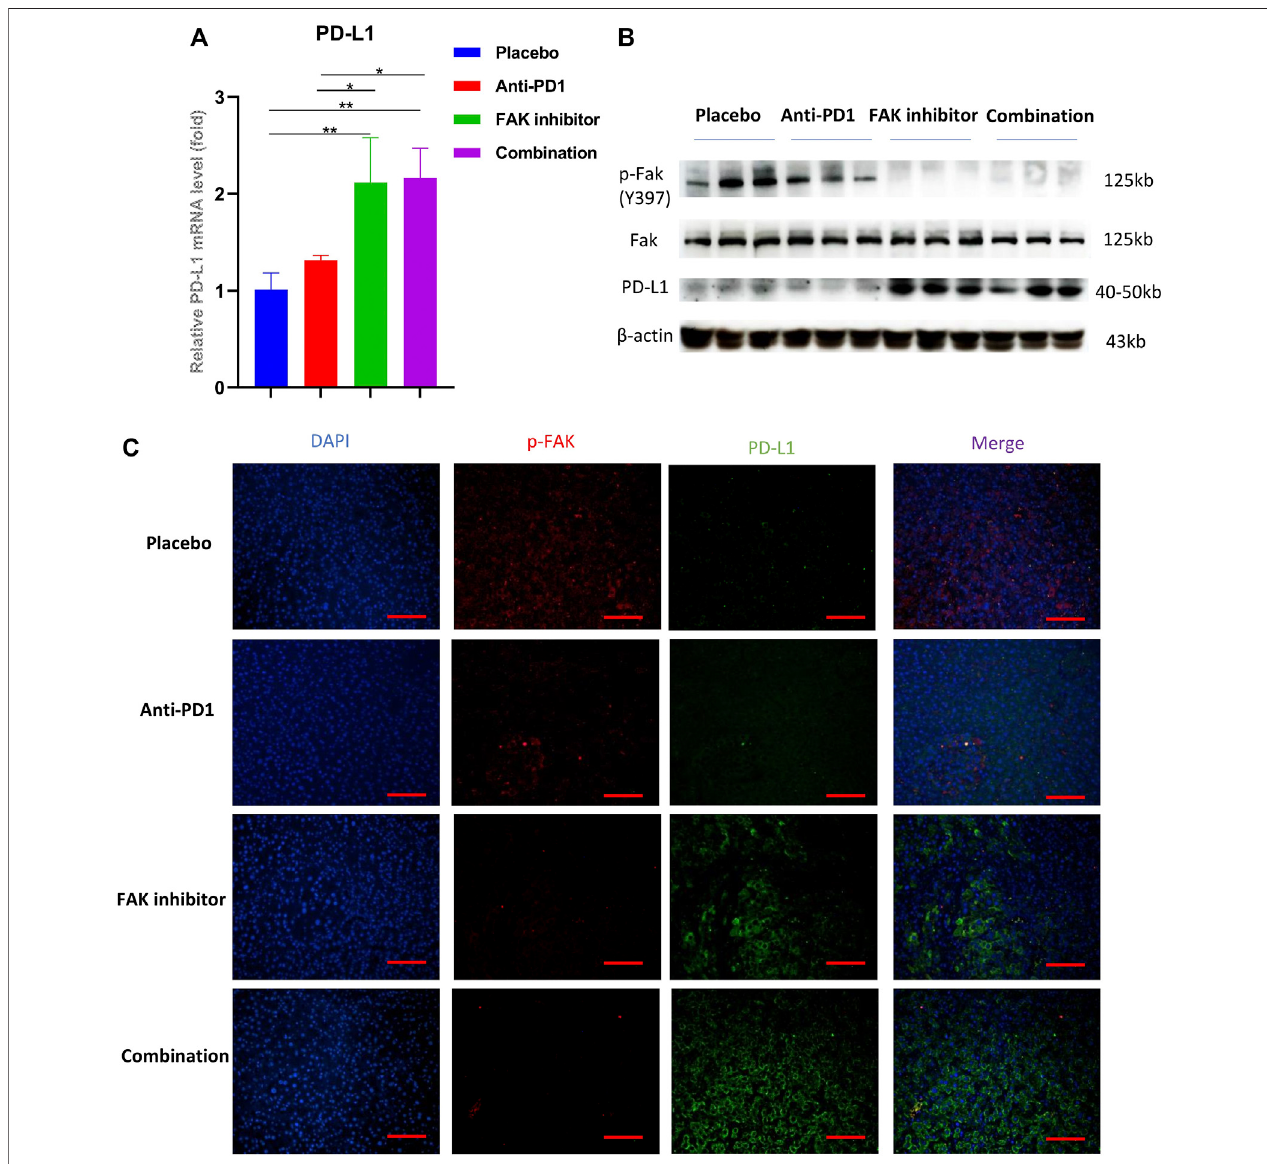
FIGURE 6 | FAK inhibition increased the expression of PD-L1 in HCC (A) The mRNA expressions ofPD-L1 in HCC in mice detected by q-PCR ( n (cid:1) 3 mice/group). Signi fi cance identi fi cation: ns, p ≥ 0.05; *, p < 0.05; **, p < 0.01; ***, p < 0.001. (B) The expression levels of p -Fak (Y397), Fak and PD-L1 in HCC in mice detected by Western Blotting ( n (cid:1) 3 mice/group). (C) Immuno fl uorescence staining of p -FAK and PD-L1 in HCC in mice (scale bar, 200 μ m).